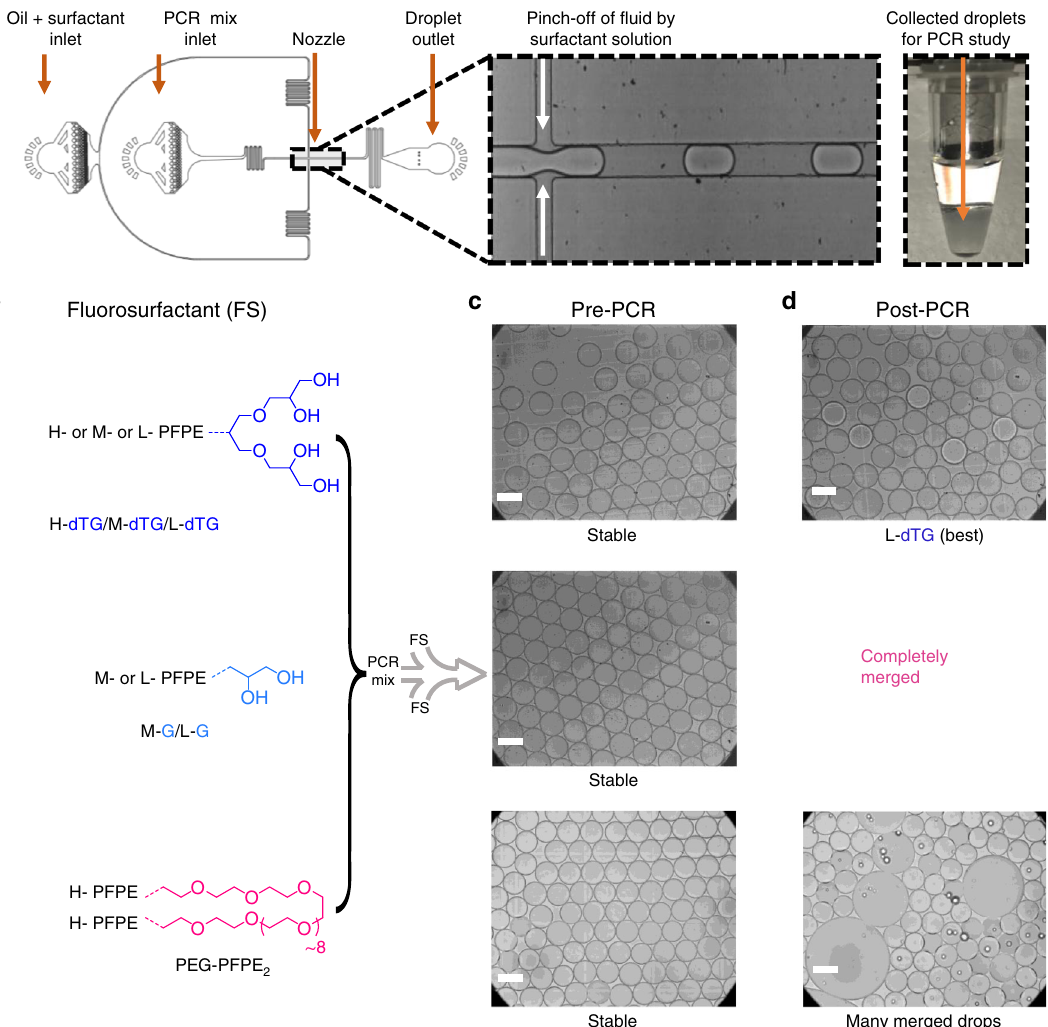
Fig. 2 Polar head group geometry dictates droplet stability. a Polydimethylsiloxane (PDMS) based micro fl uidic devices are used to prepare microdroplets containing PCR reagents. b The three tri-glycerol (dTG)-based surfactants (H-dTG, M-dTG, L-dTG), the two mono-glycerol (G)-based surfactants (M-G, L-G), and the PEG600-based fl uorosurfactant, PEG-PFPE 2 , were used to create droplets for stability testing (chemical structures in b ). c Droplets produced using the tri-glycerol, the mono-glycerol, and the PEG600-based surfactants showed no merging during >24 h incubation at 4 °C ( c showing pre-PCR droplets). d After 35 cycles of PCR, L-dTG-stabilized droplets showed almost no merging. In contrast, droplets generated using mono-glycerol (G)-based surfactants (M-G, L-G) merged completely during the PCR. Droplets stabilized with PEG-PFPE 2 surfactant showed substantial merging ( c depicting post- PCR droplets). Scale bar, 100 µ